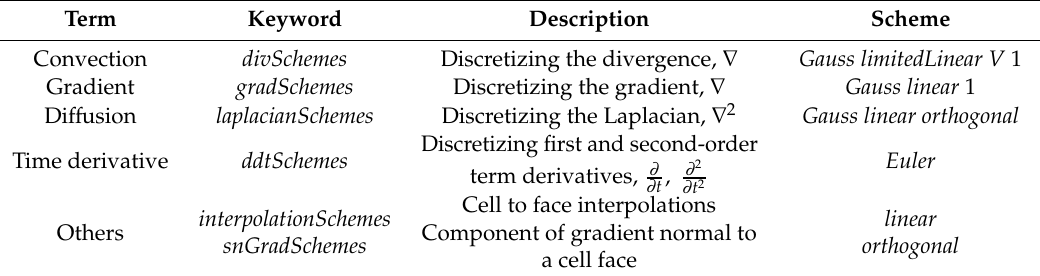
Table 5. Numerical discretization schemes.